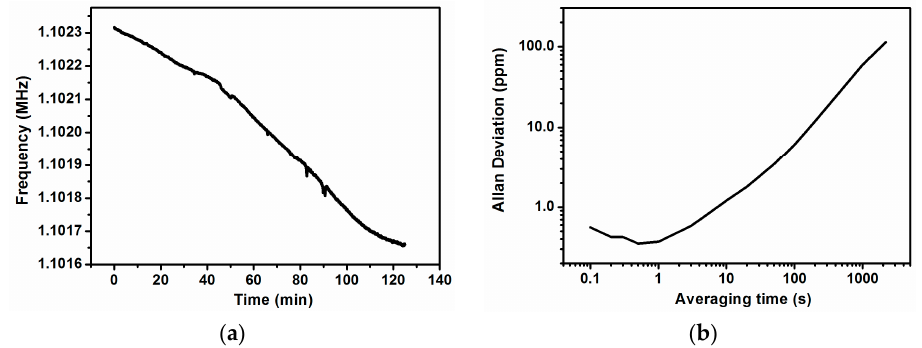
Figure 4. ( a ) Frequency stability measured in closed-loop configuration for 120 min. There is a clear long term drift; ( b ) Allan deviation in ppm for the closed-loop measurements with Vdc = 24 V and taking measures every 0.1 s. The minimum Allan deviation is near 1 s of averaging time.